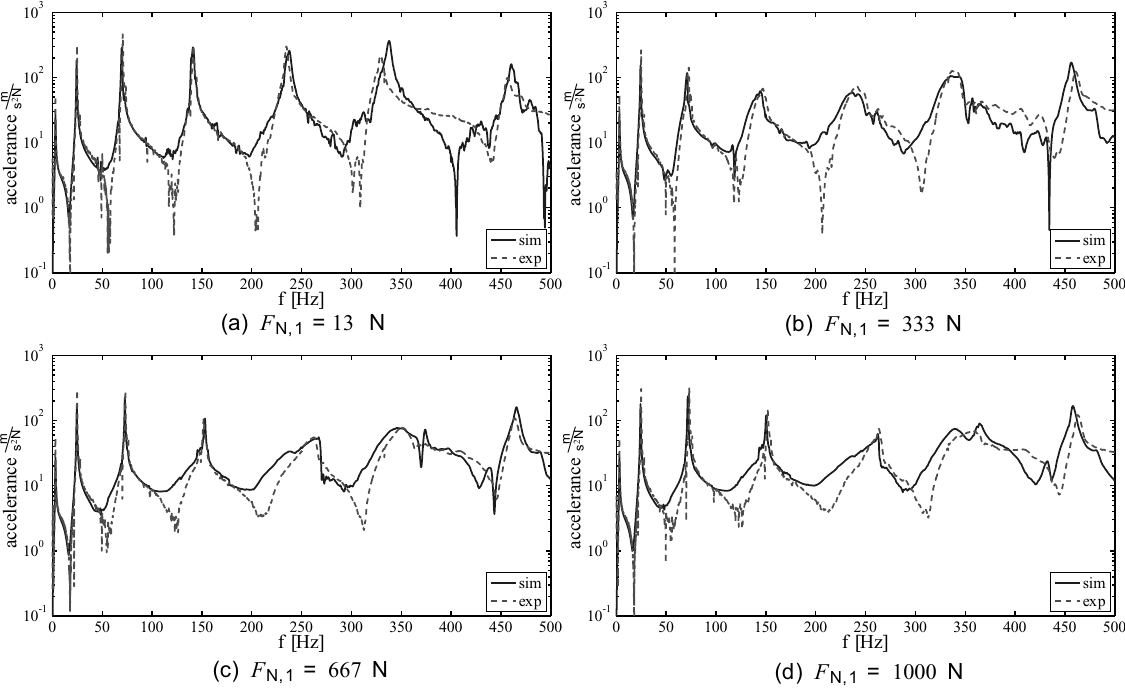
Fig. 10. Comparison of measured and simulated FRFs for best match parameter case (cf. Table